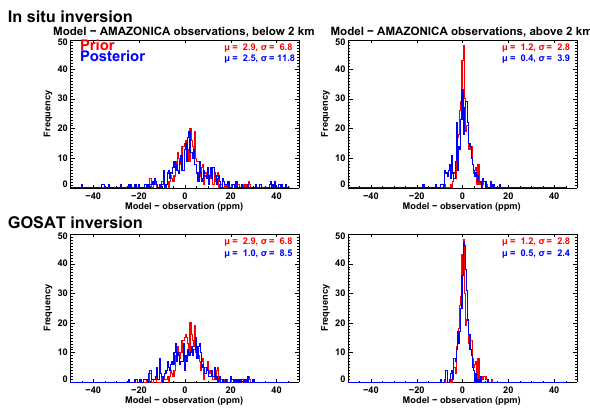
Figure 4. Comparison of model and Amazon aircraft observa- tions (Amazonica project) over the period of overlap, January– September 2010. Top two panels show model-observation differ- ence histograms for the in situ only inversion and bottom two pan- els show results for the GOSAT only inversion. Comparisons are shown separately for model and data below 2km altitude (left) and above 2km (right). Mean differences and standard deviations are indicated in the